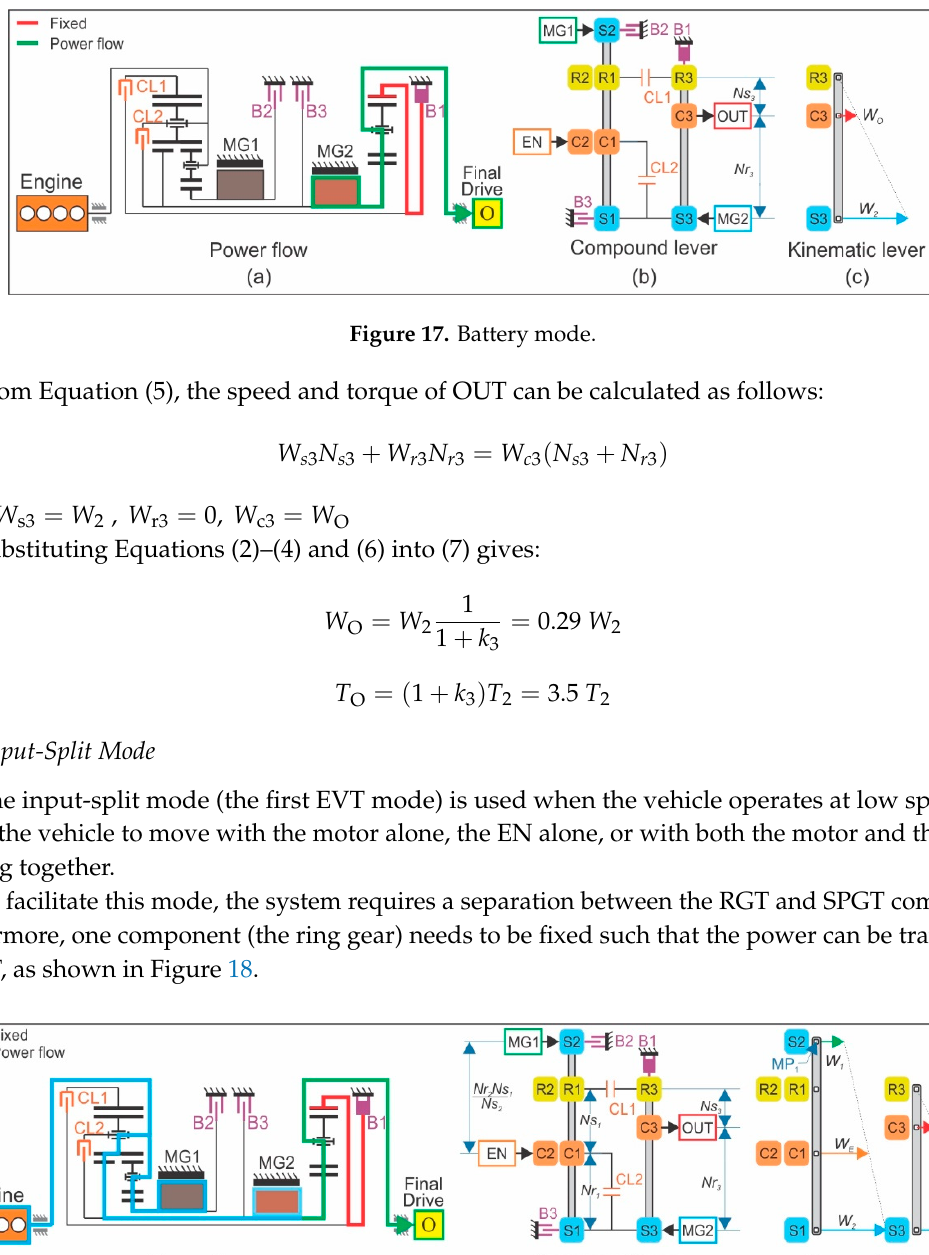
Figure 16. HT system and mode switching diagram considered in kinematic analysis.